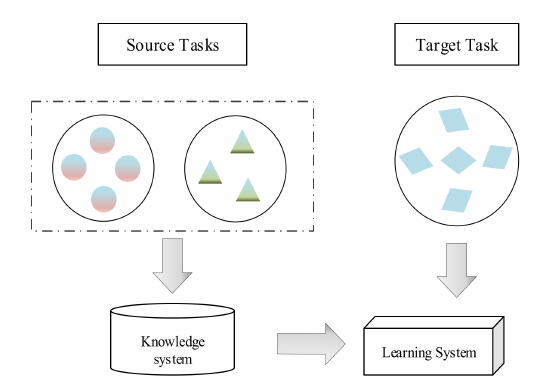
Figure 4. Traditional deep learning.